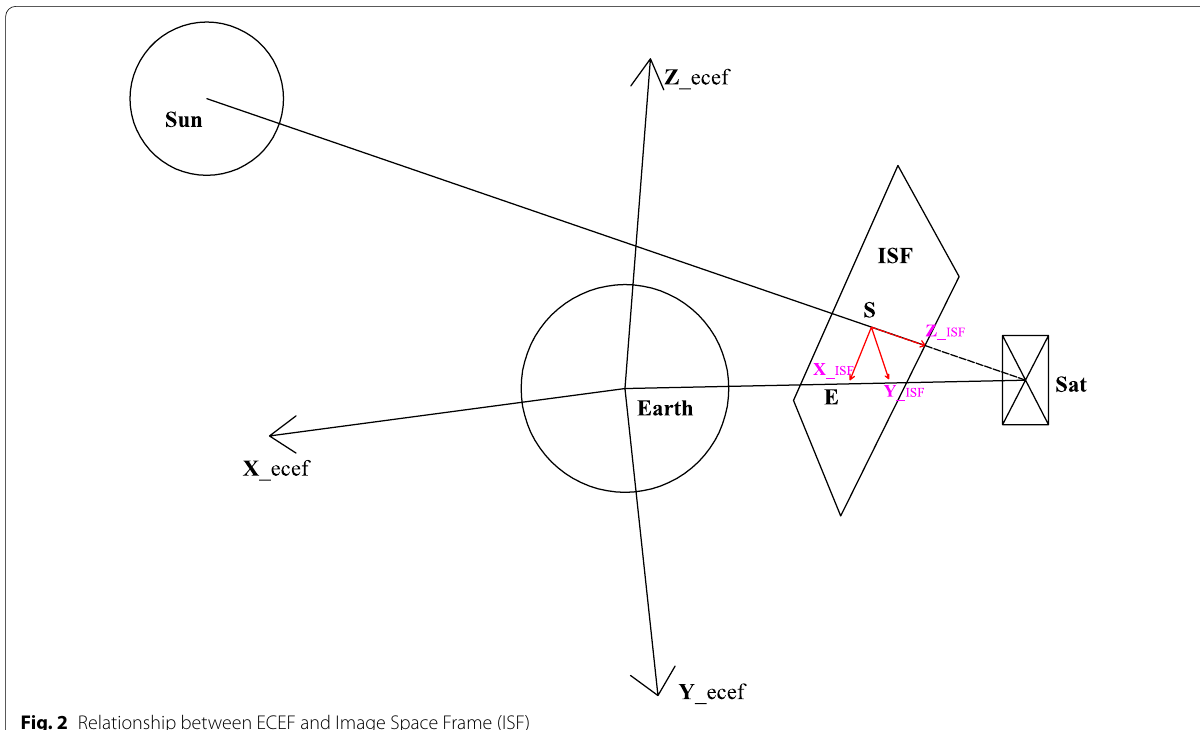
Fig. 2 Relationship between ECEF and Image Space Frame (ISF)